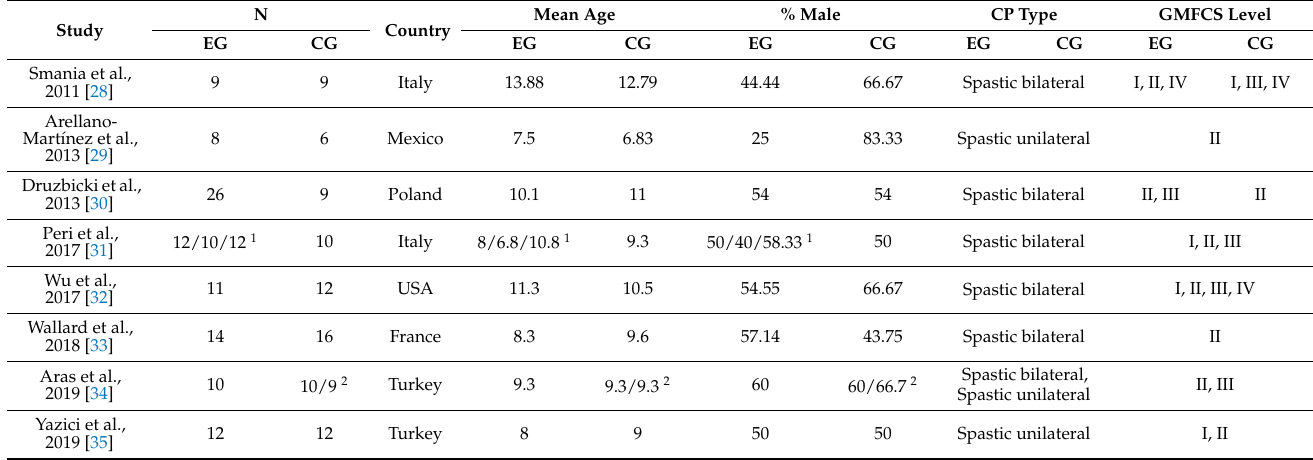
Table 1. Characteristics of patients for included